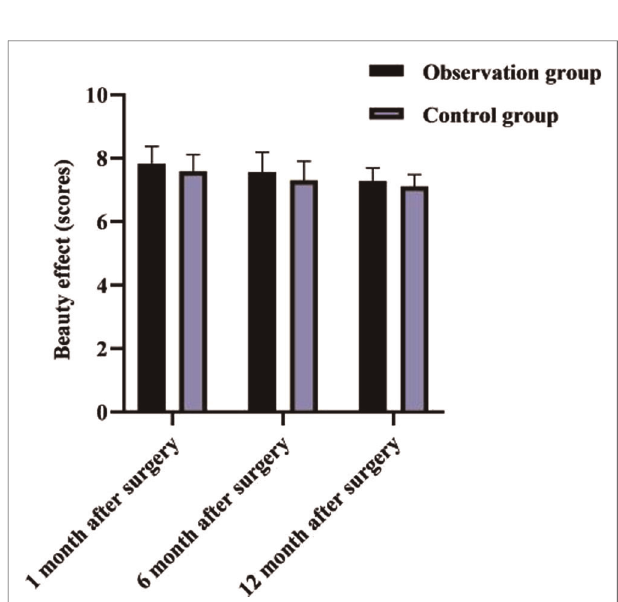
FIGURE 4 | Comparison of cosmetic effect between two groups in each month after surgery ( (cid:1) x + s , score).